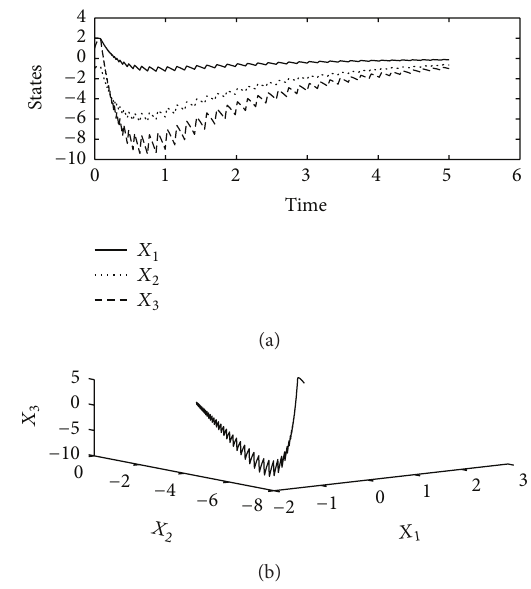
Figure 1: (a) Timing response of the three states and (b) state space